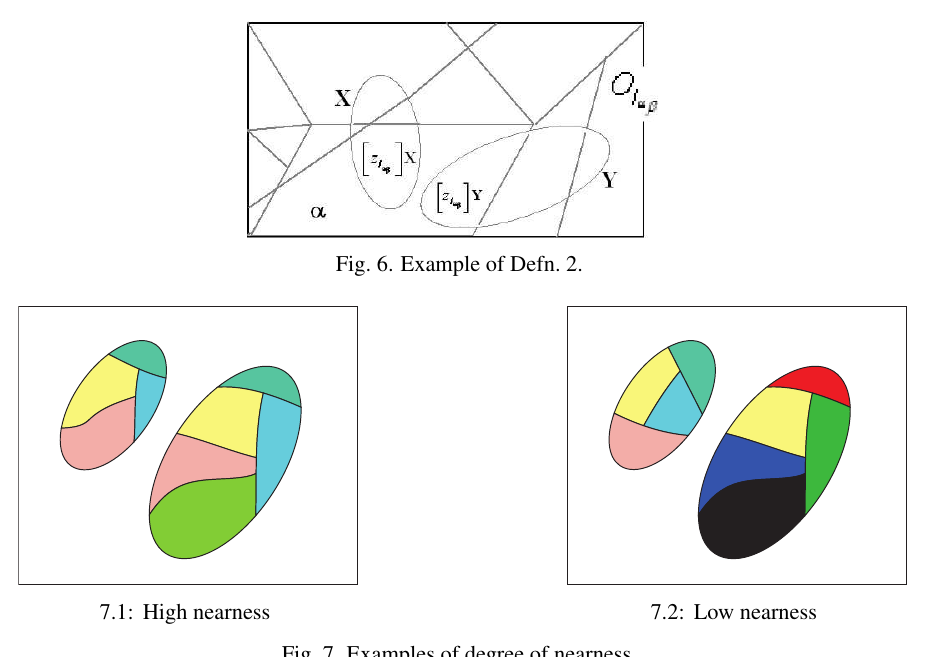
Fig. 7. Examples of degree of